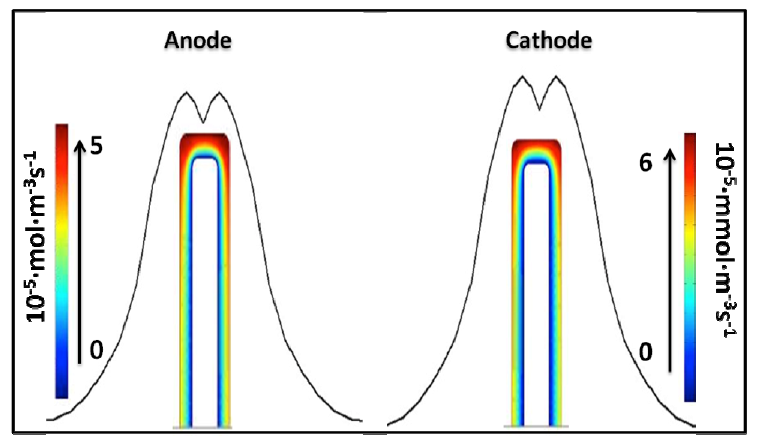
Figure 4. Change in reaction rate along the surface of anode and cathode at electrode height of 200